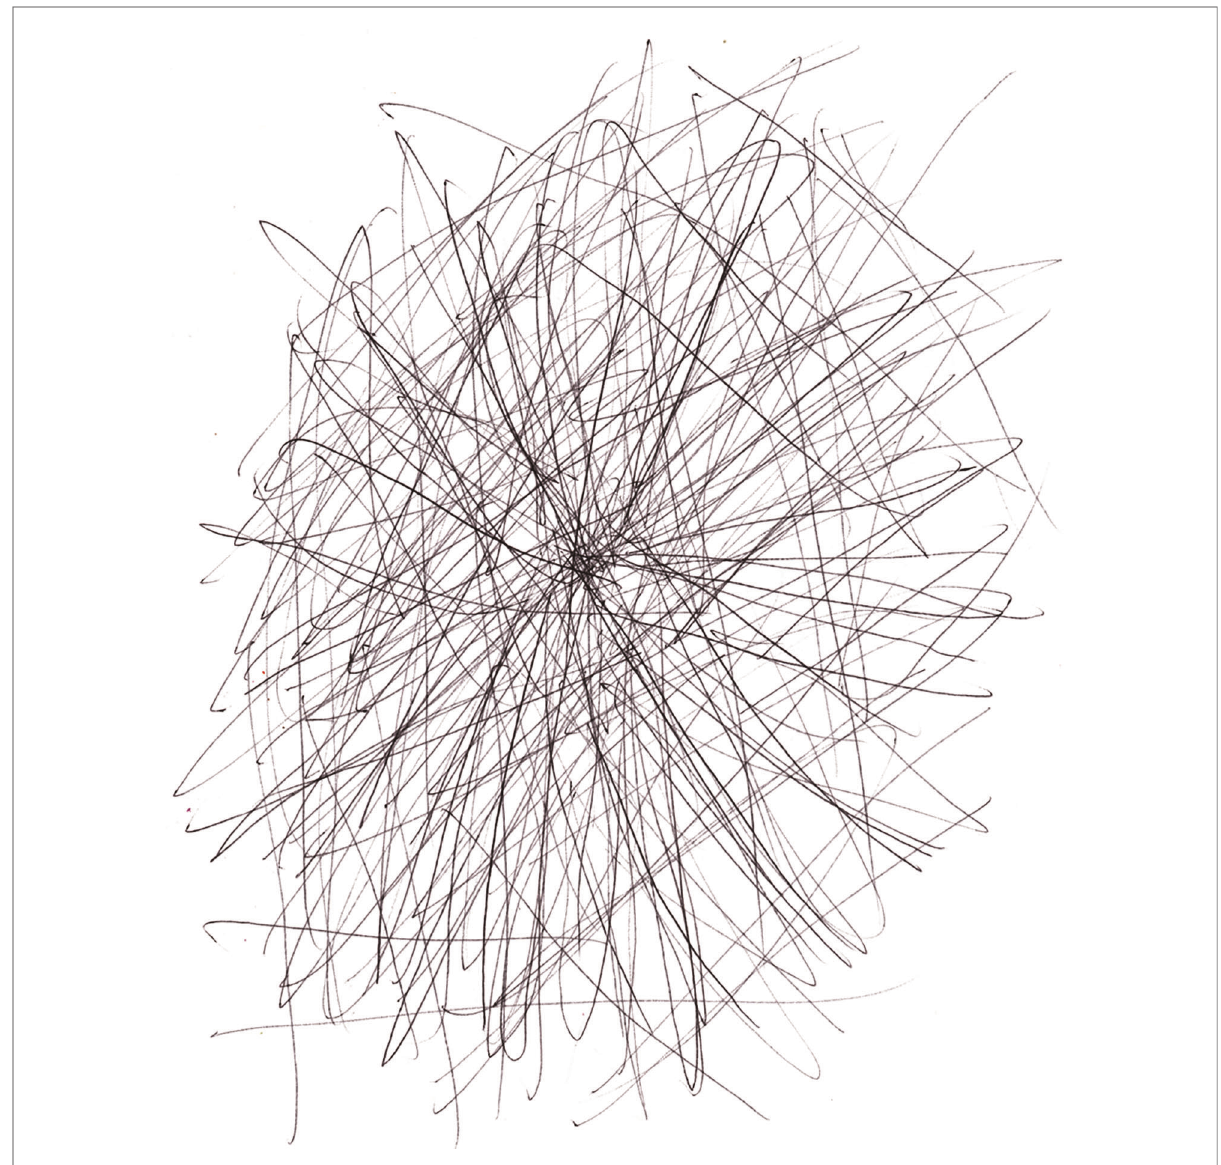
FIGURE 6 Pain as radiating black